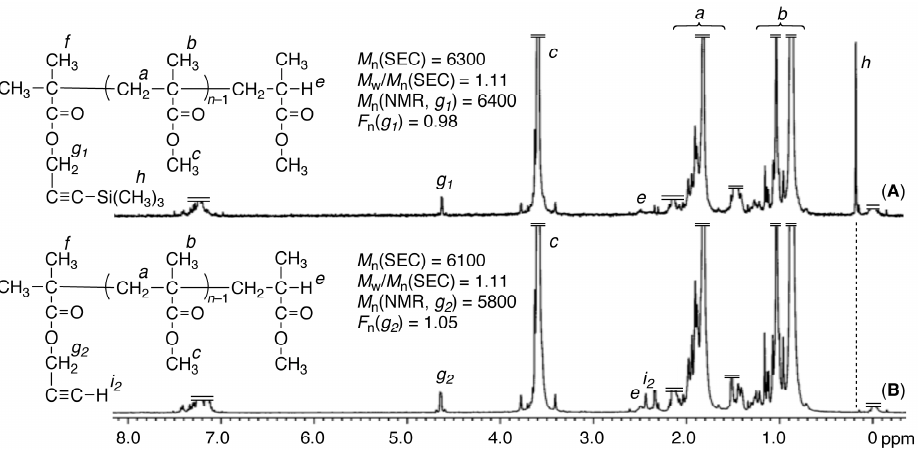
Figure 4. 1 H NMR spectra (in CDCl 3 at 55 ◦ C) of st -50-PMMAs obtained in anionic polymerization of MMA with DPHLi/ 1 in THF at − 100 ◦ C and subsequent procedures: ( A ) Quenching the polymerization ([M] 0 /[DPHLi] 0 /[1] 0 = 924/34/51) with acidic methanol; ( B ) Deprotection of Me 3 Si-group by n -Bu 4 NF Me 3 Si-group by n -Bu 4 NF in THF at 0 °C ([Me 3 Si–] 0 /[ n -Bu 4 NF] 0 = 10/20 mM). in THF at 0 ◦ C ([Me 3 Si–] 0 /[ n -Bu 4 NF] 0 = 10/20